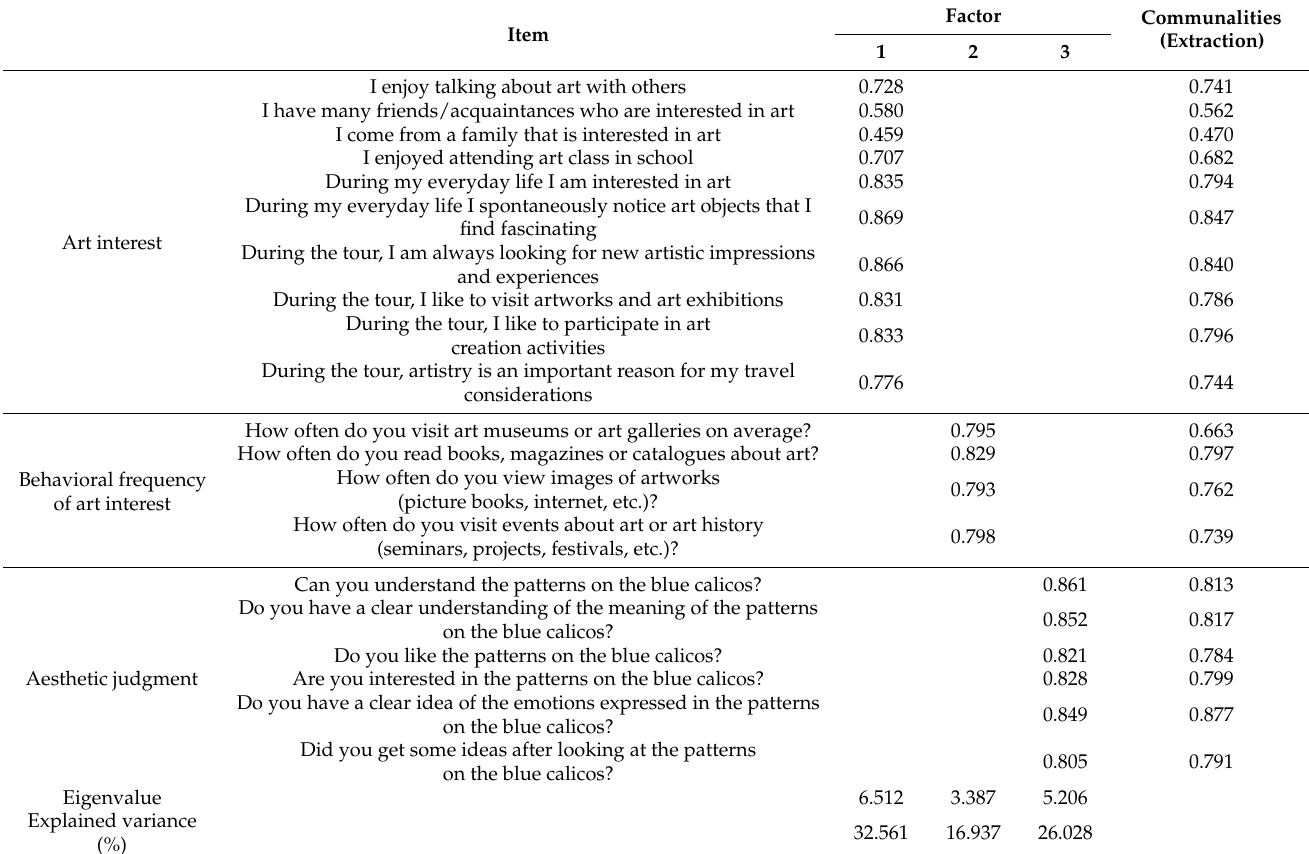
Table 3. Results of exploratory factor analysis